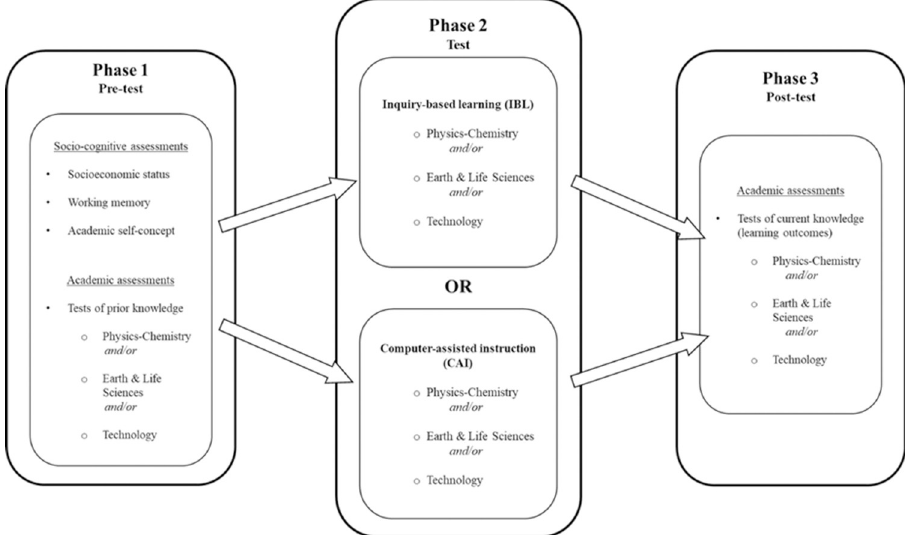
Fig 2. The experimental design of the present study. The pedagogical material and academic test metrics in Physics- Chemistry, Earth and Life Sciences, and Technology were collaboratively elaborated by teams of teachers from each discipline. All data were collected in real classroom environments via an online platform dedicated to the present research, including demographics, academic tests, questionnaires, and WM measures.